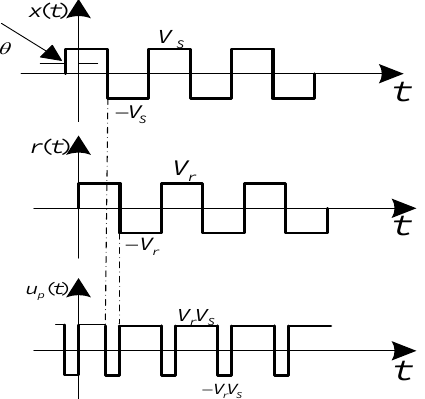
Figure 5. Phase-sensitive measurement waveform.